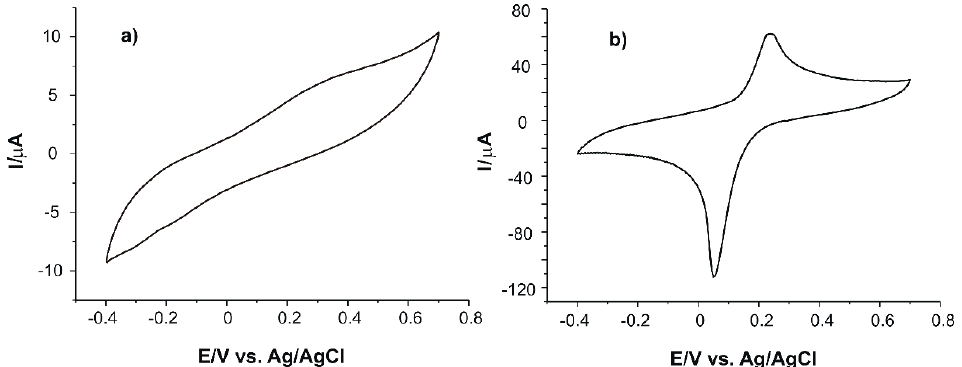
Figure 5. Cyclic voltammograms of sensors SPCE ( a ) and PB/SPCE ( b ) immersed in a solution obtained from the pharmaceutical product Fluxiv, recorded at the scan rate of 0.1 V · s − 1 . In the case of SPCE, a large anodic peak (E pa = 0.285 V, I pa = 5.66 µA) was observed. The PB/SPCE sensor presented an anodic (E pa = 0.235 V; I pa = 61.9 µA) and a cathodic (E pc = 0.050 V; I pc = − 111.78 µA) peak. In both cases, the peaks were related to the presence of diosmin, but with the other active compounds from the pharmaceutical product. From this data, it can be concluded that the PB/SPCE sensor has a higher sensitivity than SPCE, with the current of the anodic peak being 10 times higher.